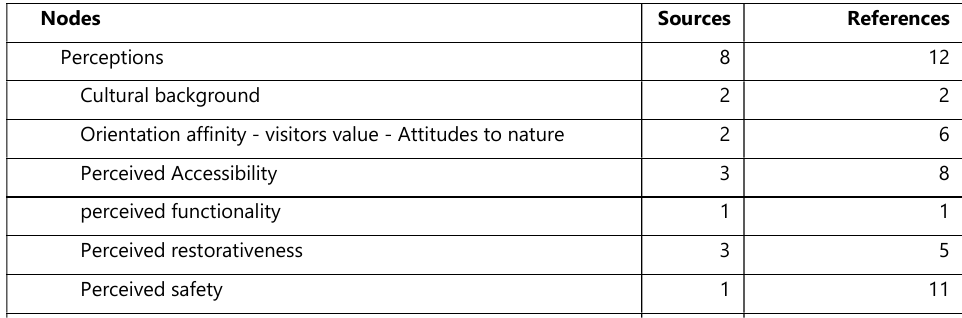
Table 1: NVivo nodes (generated themes), sources (number of articles) and references (the number of times themes were referred to) (Source: